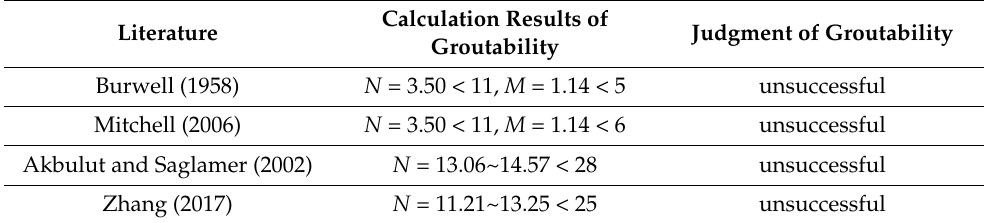
Table 5. Calculation results of groutability.